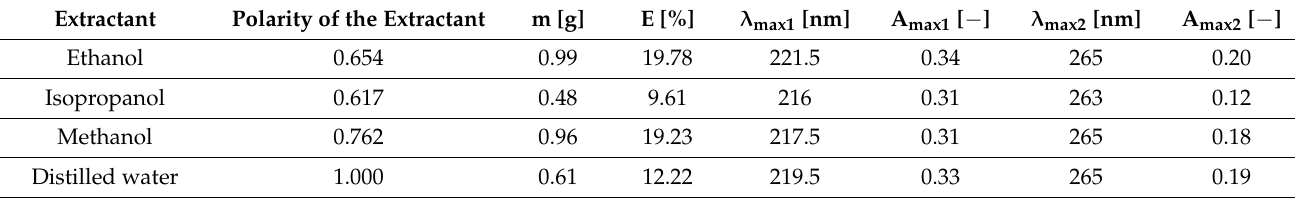
Table 1. Extraction efficiency parameters of F. alnus Mill.